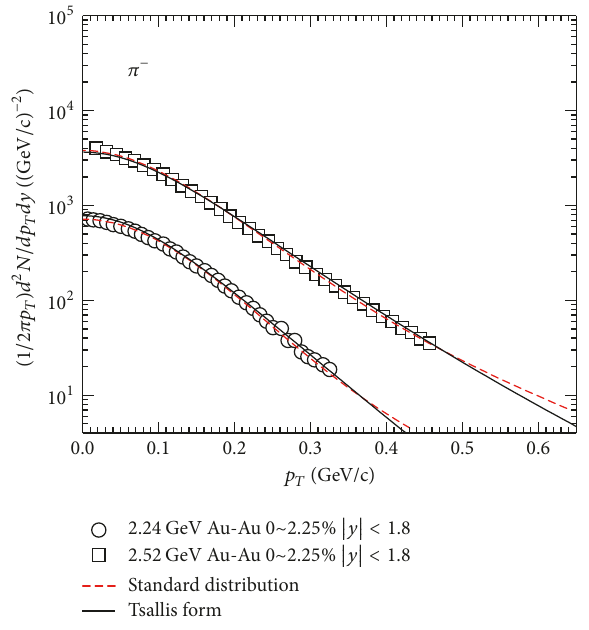
Figure 1: Transverse momentum spectra of 𝜋 − produced in cen- tral Au-Au collisions at √𝑠 𝑁𝑁 = 2.24 (circles) and 2.52 GeV (squares). The symbols represent the experimental data of the FOPI Collaboration [41] measured in midrapidity range and the last eight circles represent the simulated data of the IQMD transport code [45] which is based on Quantum Molecular Dynamics [46]. The statistical errors are smaller than the size of symbols. The dashed and solid curves are the results fitted by the two-component standard distribution and the Tsallis form of standard distribution,